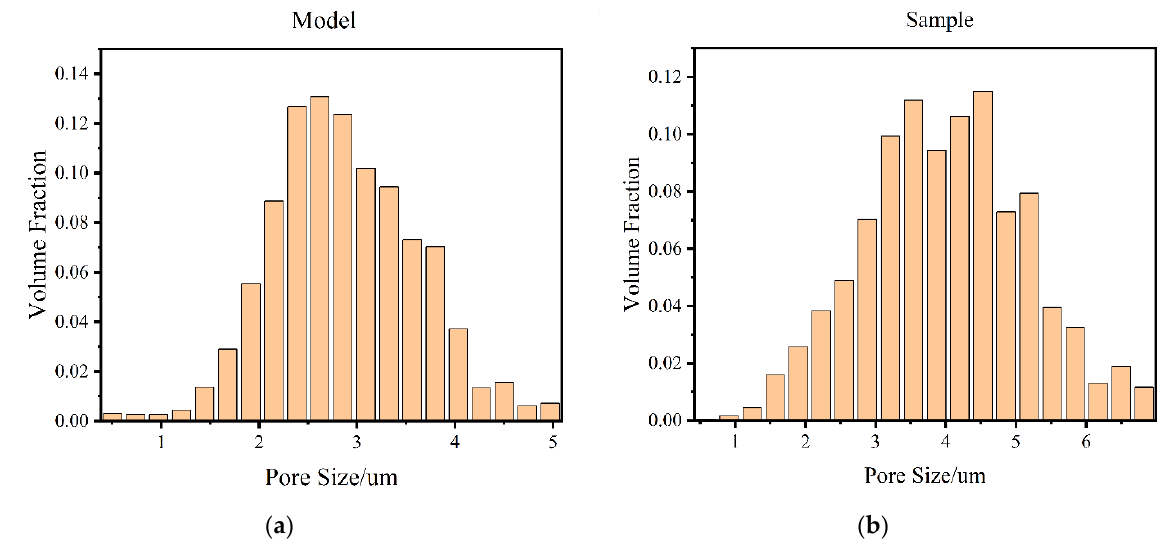
Figure 11. Pore size distribution: ( a ) Pore size distribution of the model in this study; ( b ) Pore size distribution of prepared samples.